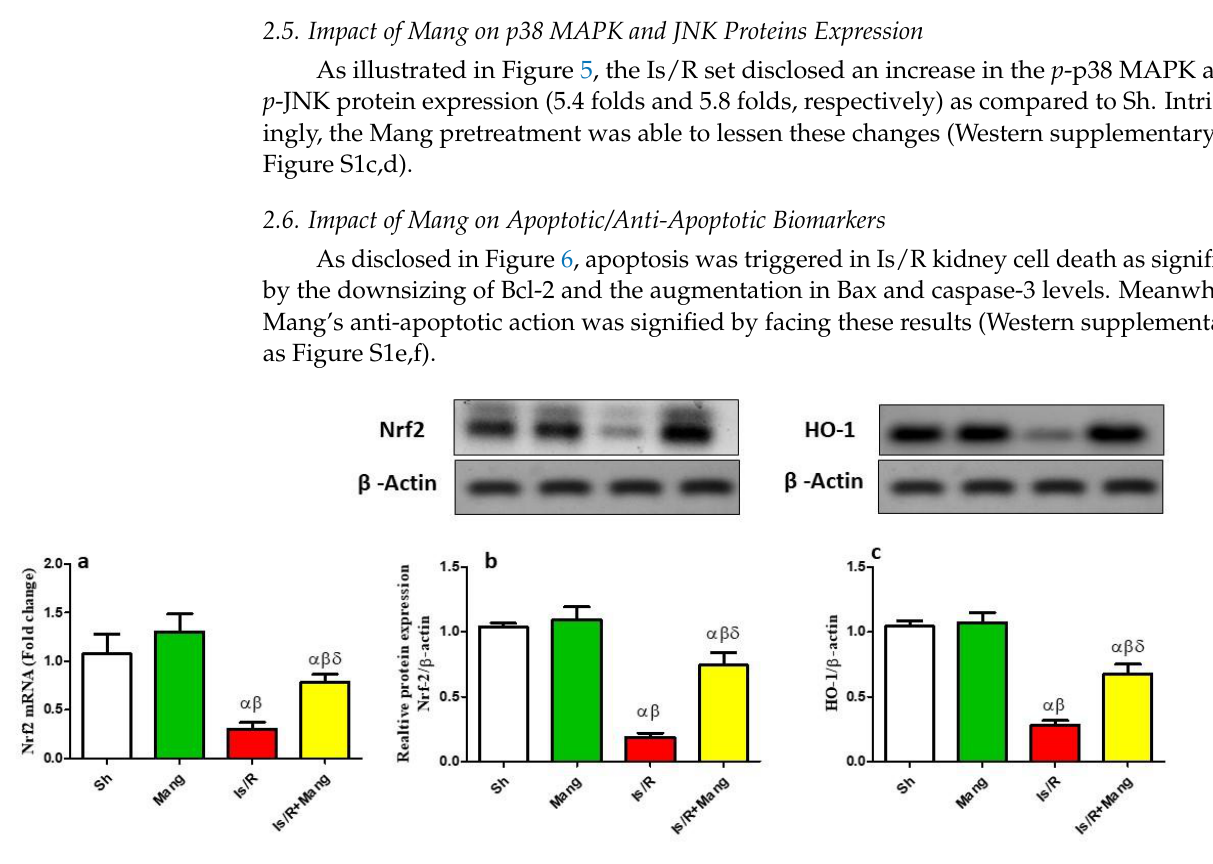
Figure 1. Mang’s (20 mg/kg, i.p) impact on renal Nrf2 either the ( a ) mRNA or ( b ) protein expression and ( c ) HO-1 protein expression as an antioxidant signaling cue. Data were articulated as the mean ( n = 7) ± SD, p value < 0.05 is significant. As compared with sham ( α ), Mang ( β ), and Is/R ( δ ) treated groups.